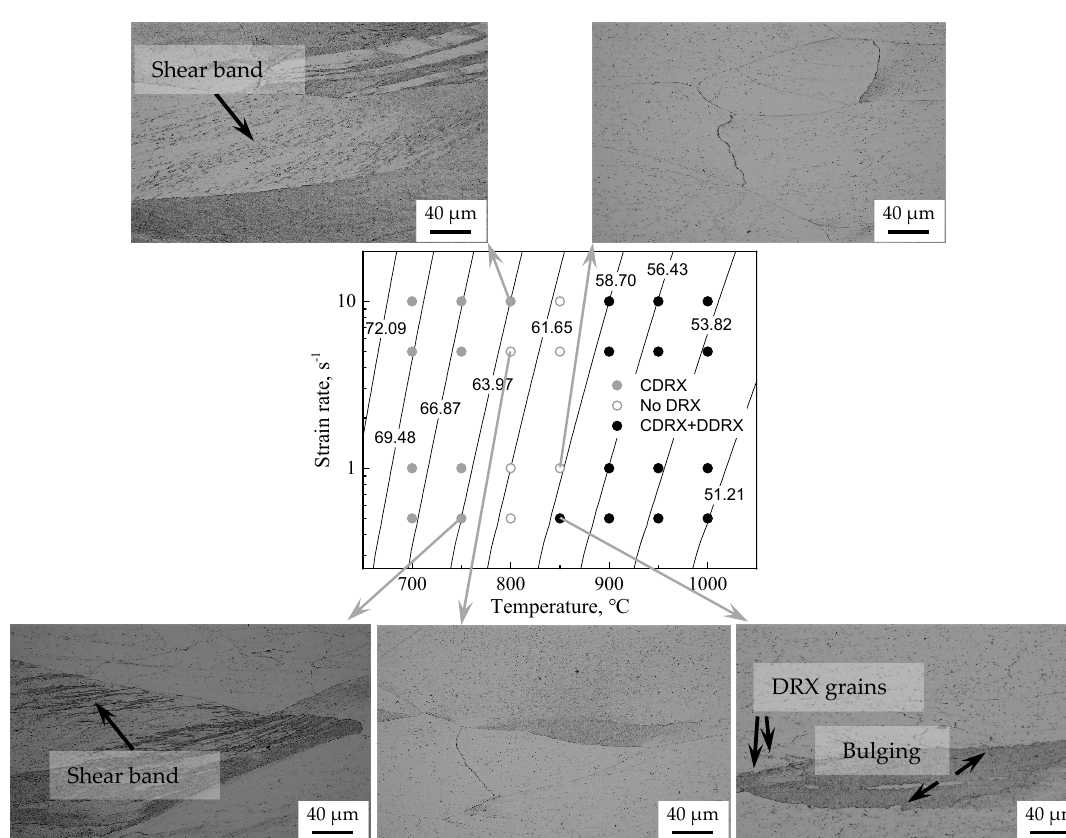
Figure 17. Contour map of Zener-Hollomon parameters and activation domain of the different DRX nucleation mechanisms over the entire strain rate and temperature range investigated. (The dynamic microstructures are also shown for several typical deformation conditions. The numbers indicate the value of ln Z.